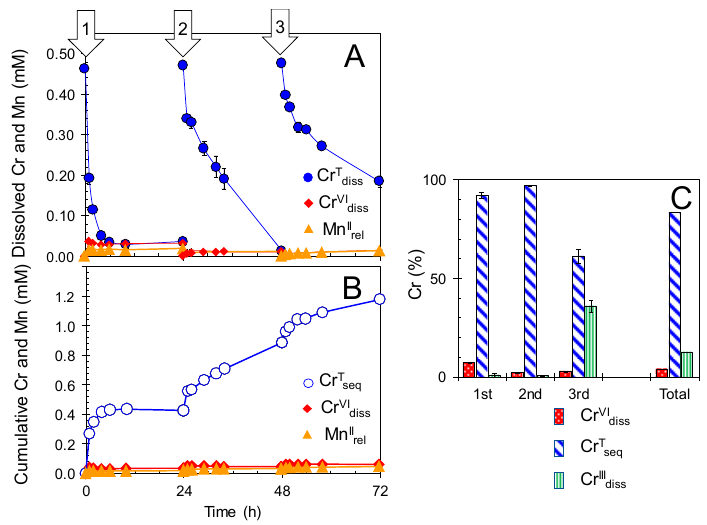
Figure 7. Repeated treatments of newly formed biogenic manganese oxides (BMOs; 1 mM as Mn) with 0.5 mM Cr(NO 3 ) 3 under anaerobic conditions at pH 6.0 (100 mM MES buffer). ( A ) Concentrations of total Cr dissolved (Cr Tdiss ), Cr(VI) dissolved (Cr VIdiss ), and Mn(II) released (Mn IIrel ). ( B ) Cumulative concentrations of total Cr sequestered (Cr Tseq ), Cr VIdiss , and Mn IIrel . ( C ) Percentages of Cr VIdiss , Cr Tseq , and Cr(III) dissolved (Cr IIIdiss ) during the repeated treatments. Bathing solutions were renewed every 24 h for 3 days (indicated by arrows). Data are shown as mean ± standard deviation (n = 3).